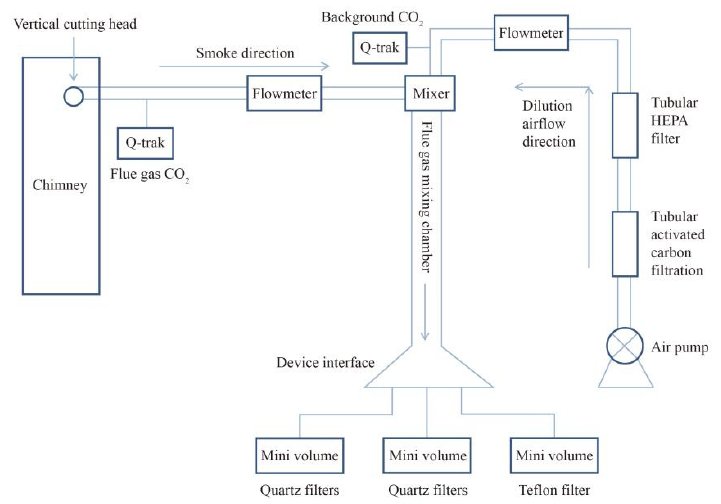
Figure 2. Structure diagram of flue gas collection device.